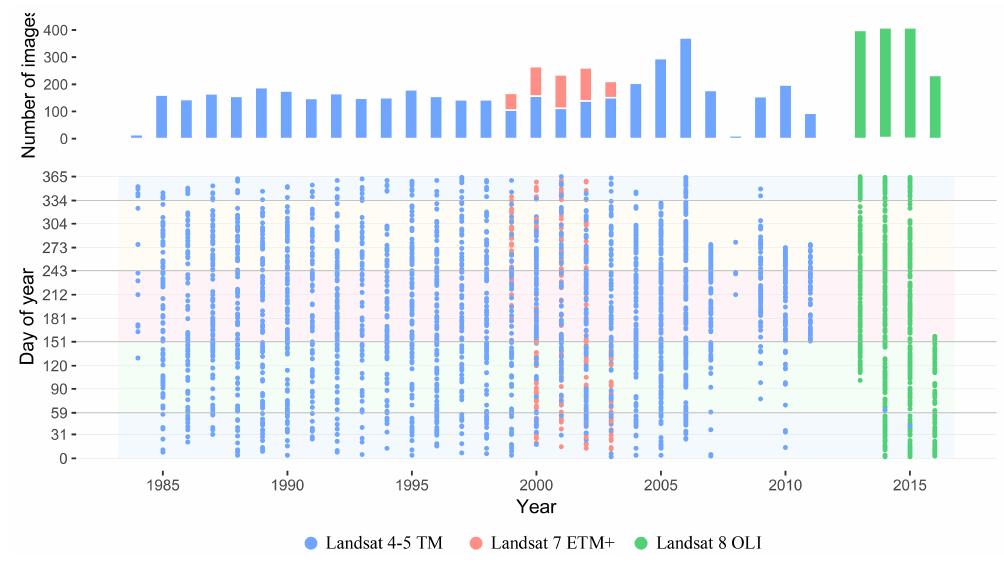
Figure 1. The acquisition time of Landsat